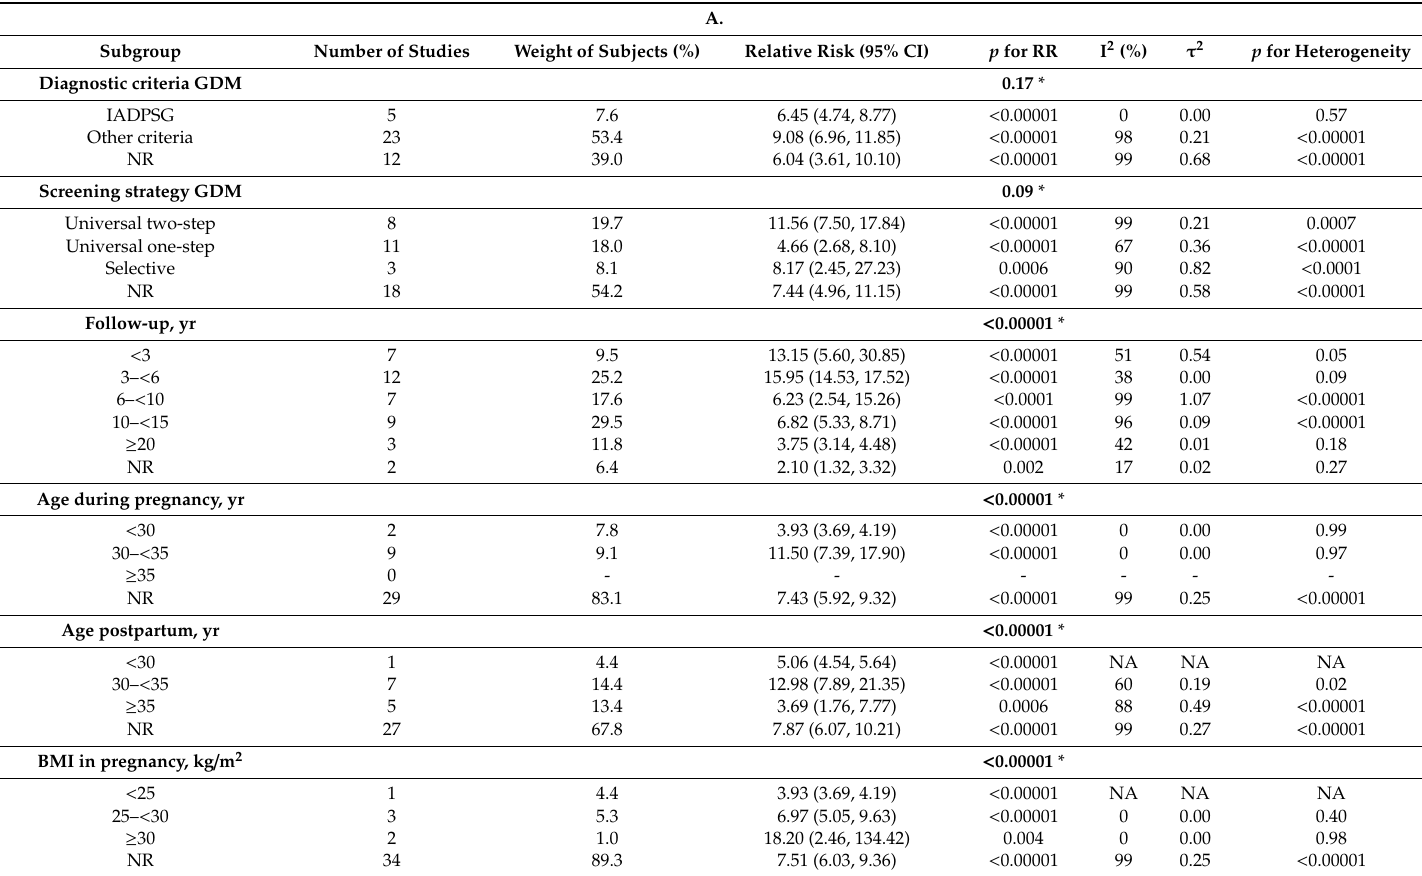
Table 2. Subgroup analyses for T2DM and prediabetes: ( A ) subgroup analyses for T2DM and ( B ) subgroup analyses for